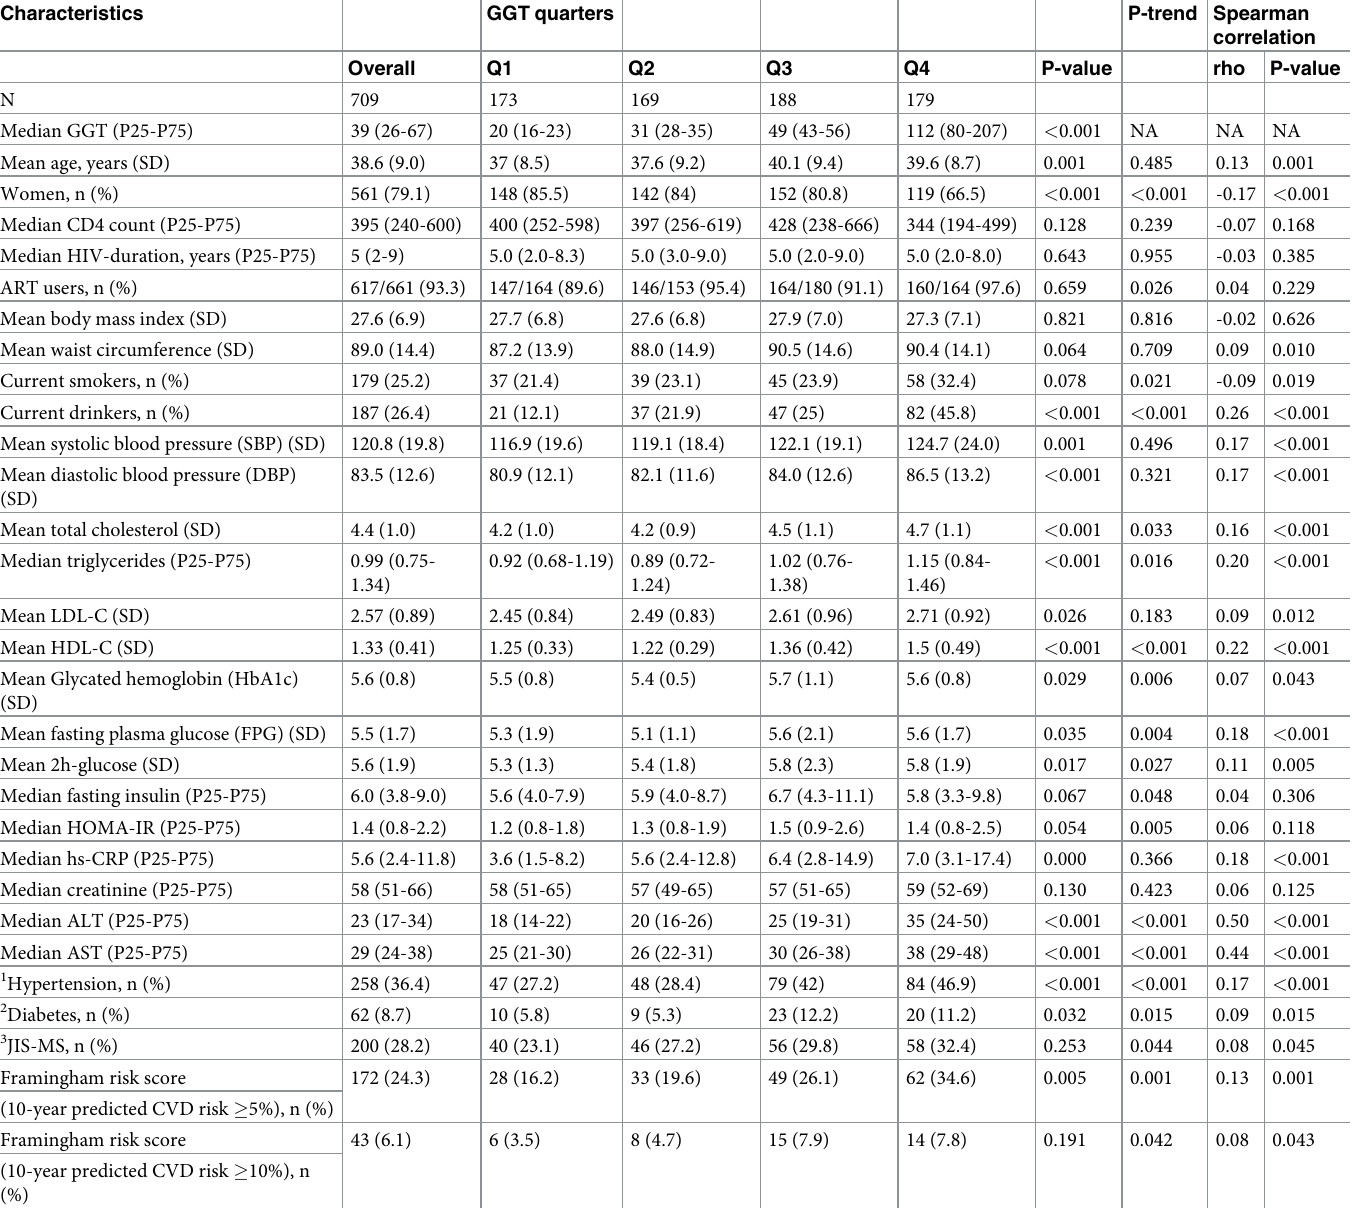
Table 1. Characteristics of participants categorised by Gamma-Glutamyl Transferase (GGT) quarters.